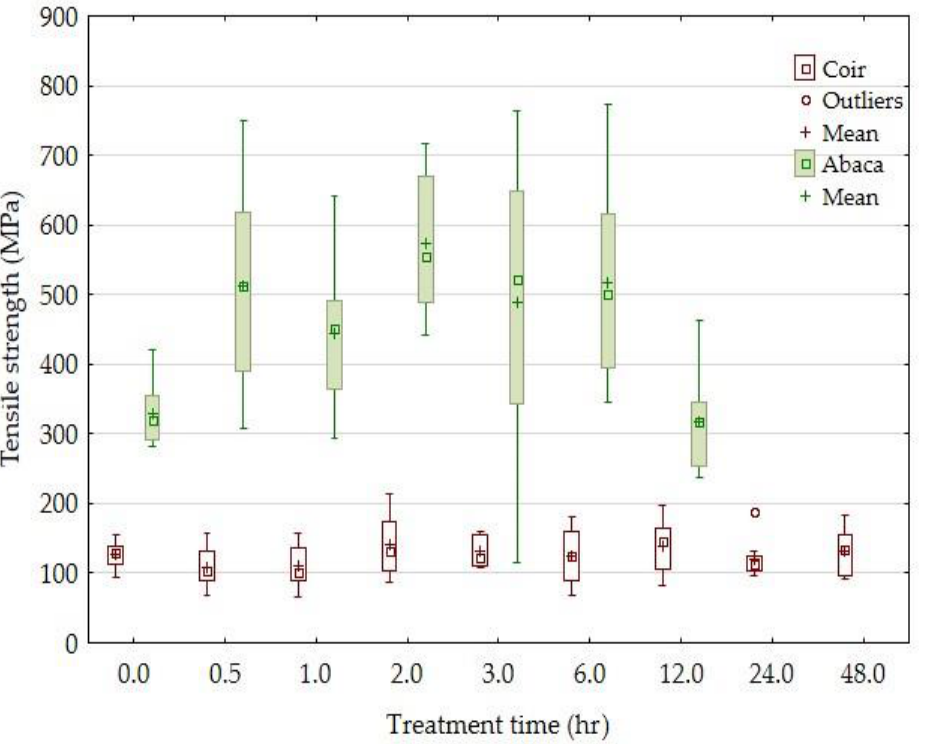
Figure 2. The dependence of the tensile strength of the coir and abaca fibers on the time of treatment in a 5% solution of NaOH.